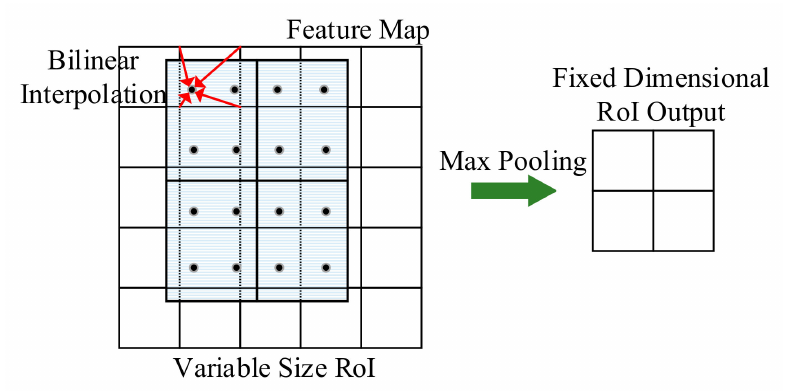
Figure 2. RoI Align